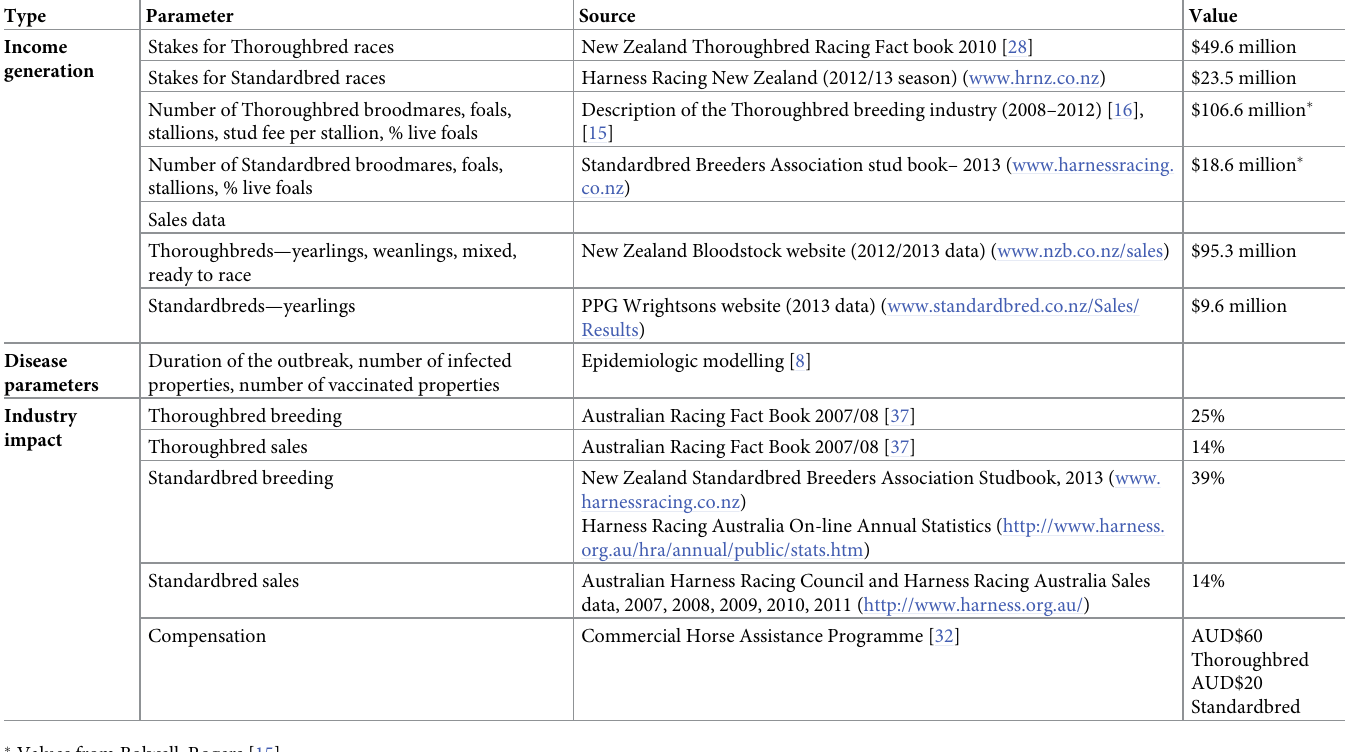
Table 2. Sources of data used for the economic analysis to determine the impact of an equine influenza outbreak on the New Zealand equine industry. Values in NZD unless specified and unadjusted for